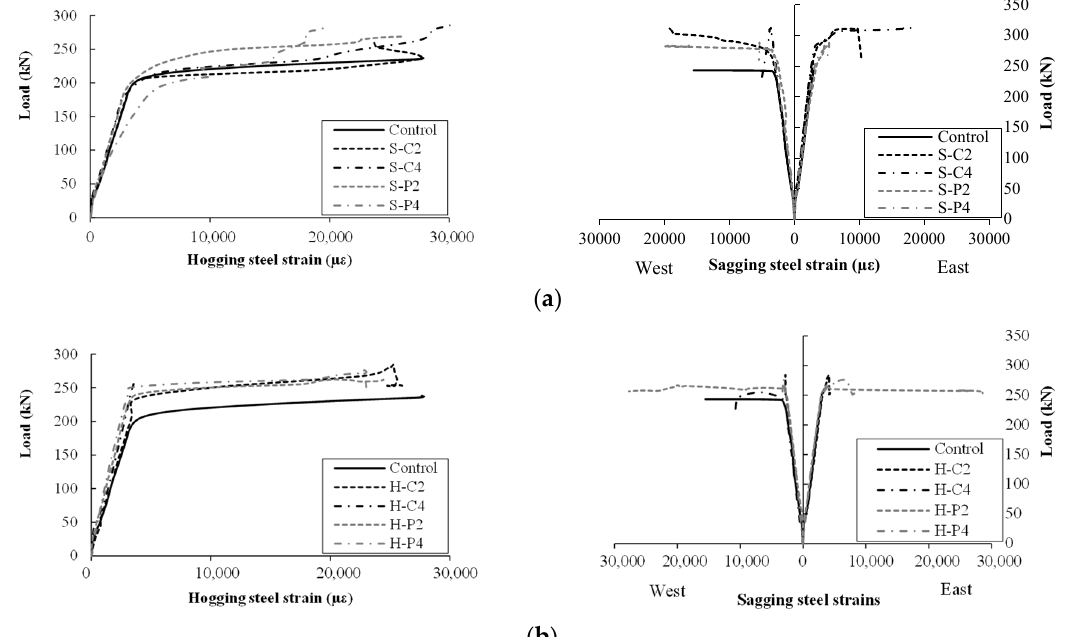
Figure 10. Steel strains: ( a ) Group A (sagging strengthening); ( b ) Group B (hogging